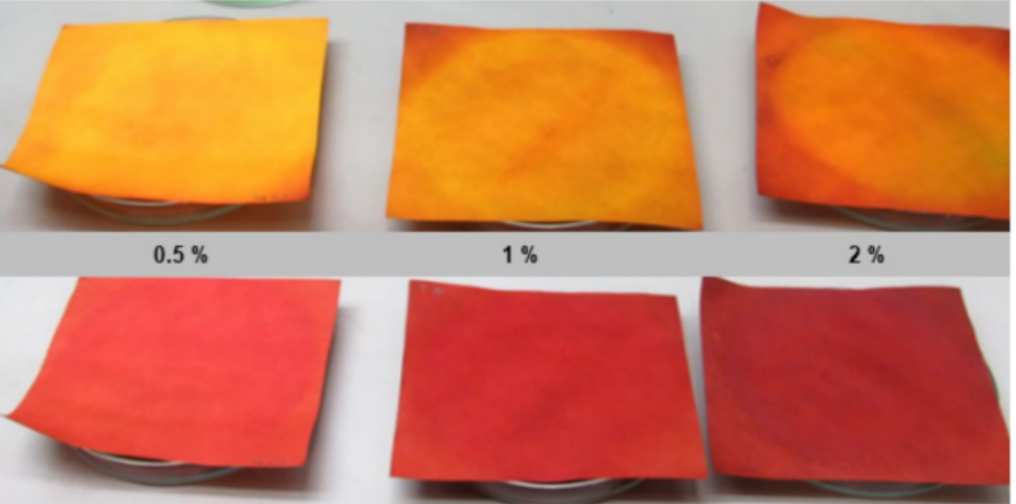
Figure 5. Illustration of the set-up used for detection of ammonia gases by substrates functionalized with pH indicators MR:MRs for 0.5, 1, and 2% (from left to